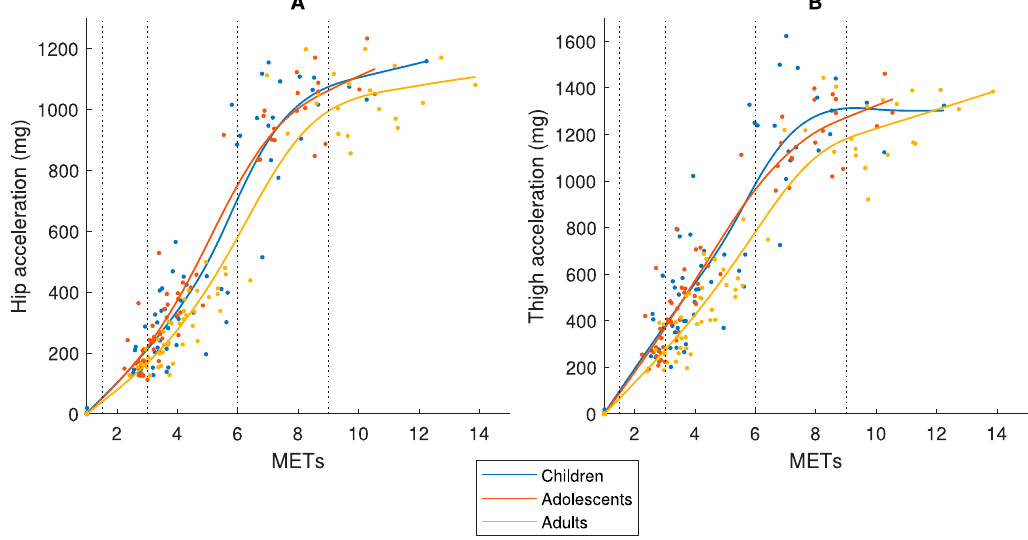
Figure 6. Calibration of the accelerometer measure of absolute PA intensity (mg) for ( A ) hip and ( B ) thigh placement in children 9–11, adolescents 14–16 and adults 23–44 years old, using the standard MET cut-points (1.5, 3.0, 6.0, 9.0) in all three groups. Table 1. Accelerometer cut-points (mg) by body placement, age-group and calibration method. Unit: mg Children